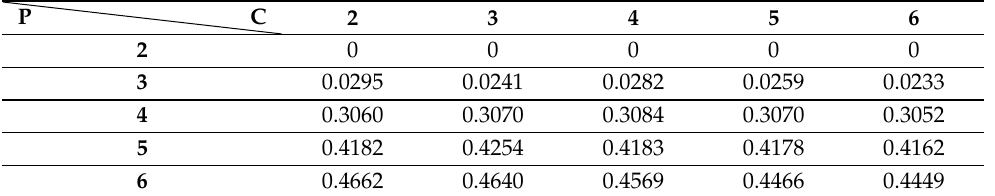
Table 4. Performance index of CGK-GM that created context flexibly.